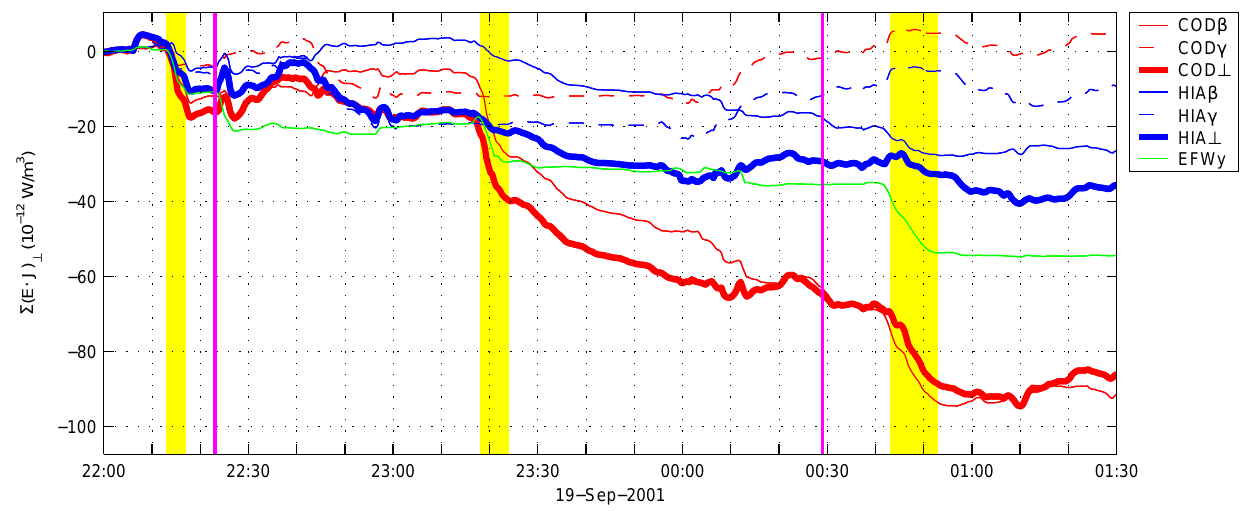
Fig. 4. Cumulative sums of the power density (thick lines) and the corresponding contributions from the perpendicular components in the MAG system, E β J β (solid lines) and E β J β (dashed lines). Data from the CODIF (red) and the HIA experiment (blue) are shown. The green line shows E β J β calculated from one of the EFW electric field components which is very close to the MAG β direction. The concentrated generator regions CGR1–CGR3 (indicated with yellow bands) appear when there are sharp gradients in the cumulative sums. The conjunctions with the FAST satellite are shown with the vertical magenta lines.